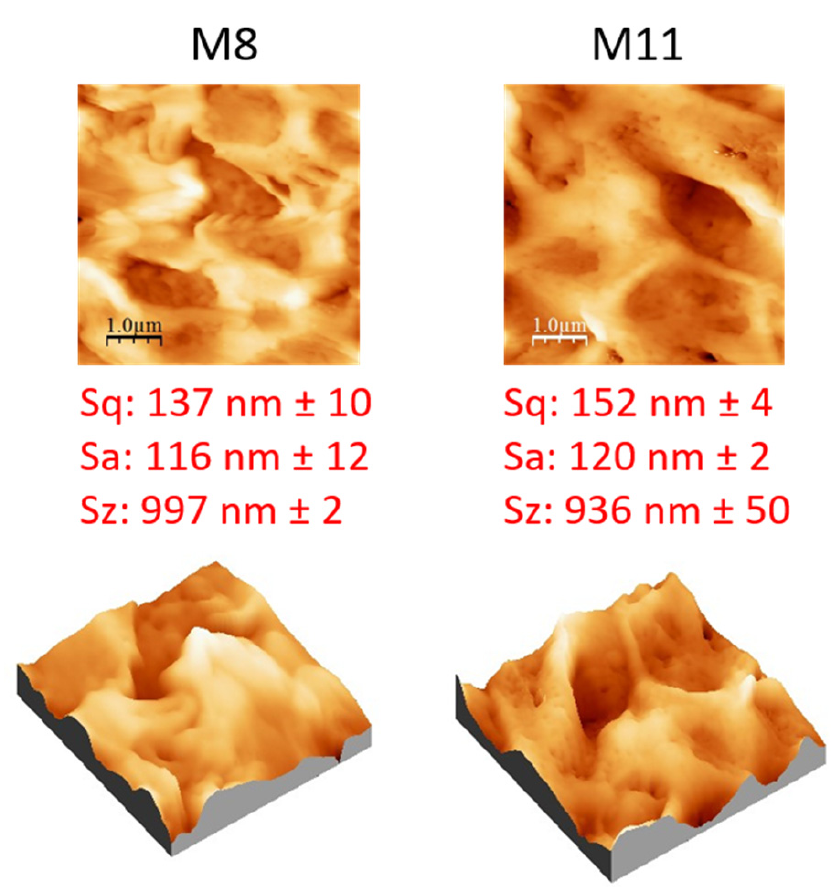
Figure 10. AFM images, with corresponding 3D views, and roughness parameters of M8 and M11